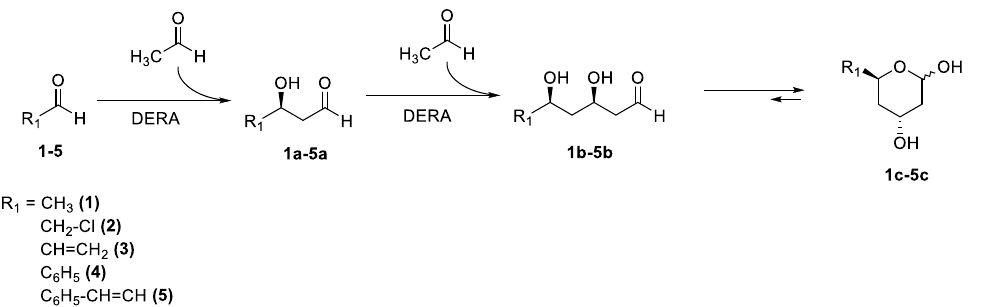
Figure 6. Overview of tested substrates and corresponding products.